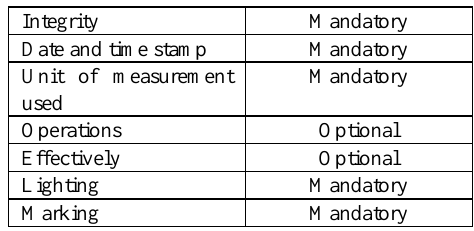
Table 3. Obstacle attributes (ICAO Annex 15, 2015)